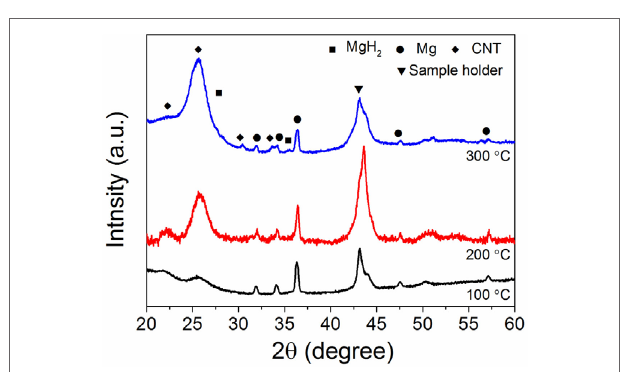
FigUre 4 | Hydrogen desorption profile of the magnesium/carbon nanotubes (CNTs) composite (CNTs was 2 mg ml –1 ) as function of the hydrogenation temperature. A heating rate of 10 °C min − 1 was used.